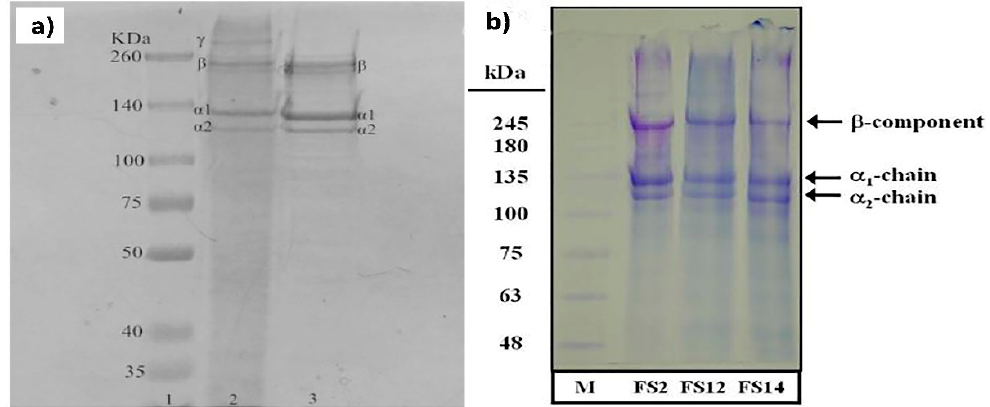
Figure 5. ( a ) Protein pattern for acid-soluble collagen from tilapia skin and scales [84]. Reprinted from with permission from Elsevier (4851441506573), and ( b ) protein pattern for extrusion-hydro-extraction (EHE) procedures from tilapia skin. Reprinted from with permission from Elsevier (4851450130304) [90] .